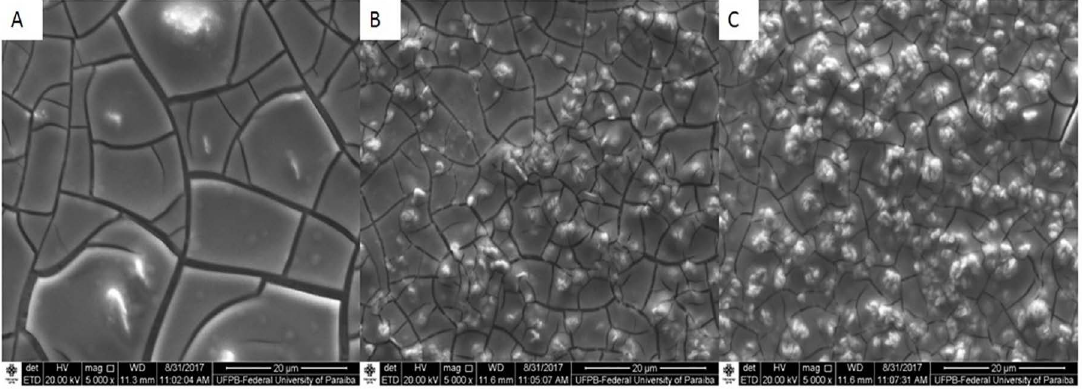
Figure 6. Micrographs of the samples 1 (a), 2 (b) and 3 (c).